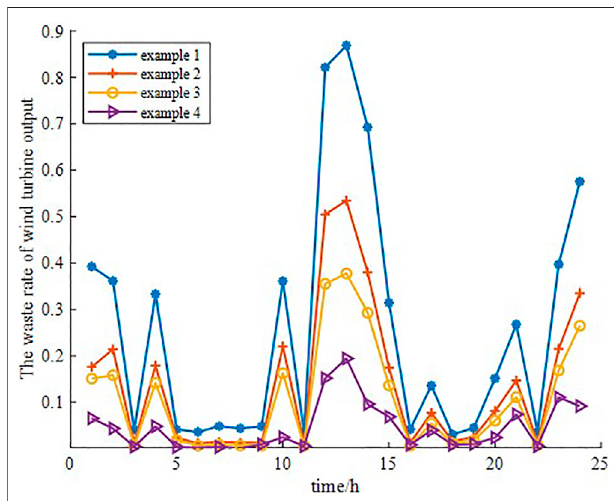
FIGURE 10 | Waste rate of wind turbine output in the four